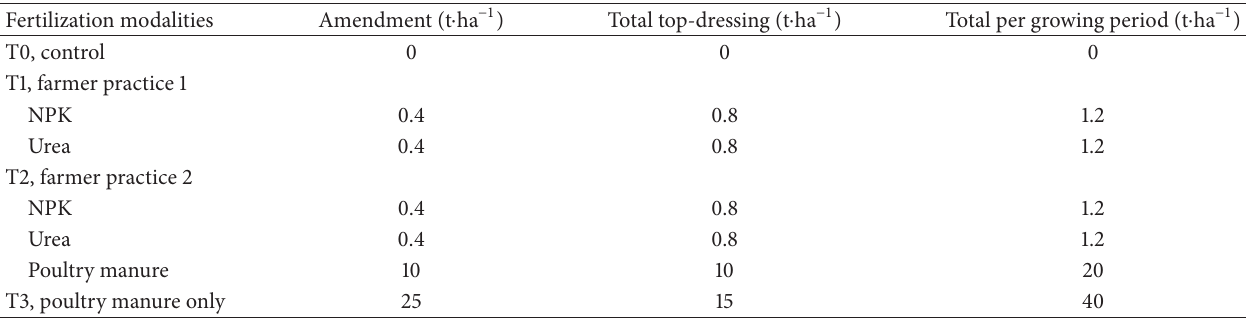
Table 1: Fertilization modalities at each growing period: application of poultry manure and mineral fertilizers on the three tested vegetable crops (eggplant, tomato, and carrot). Amendment was applied one week before sowing; top-dressing was applied twice: 2 weeks and 4 weeks after sowing (coastal area of Benin, 2009-2010, 288